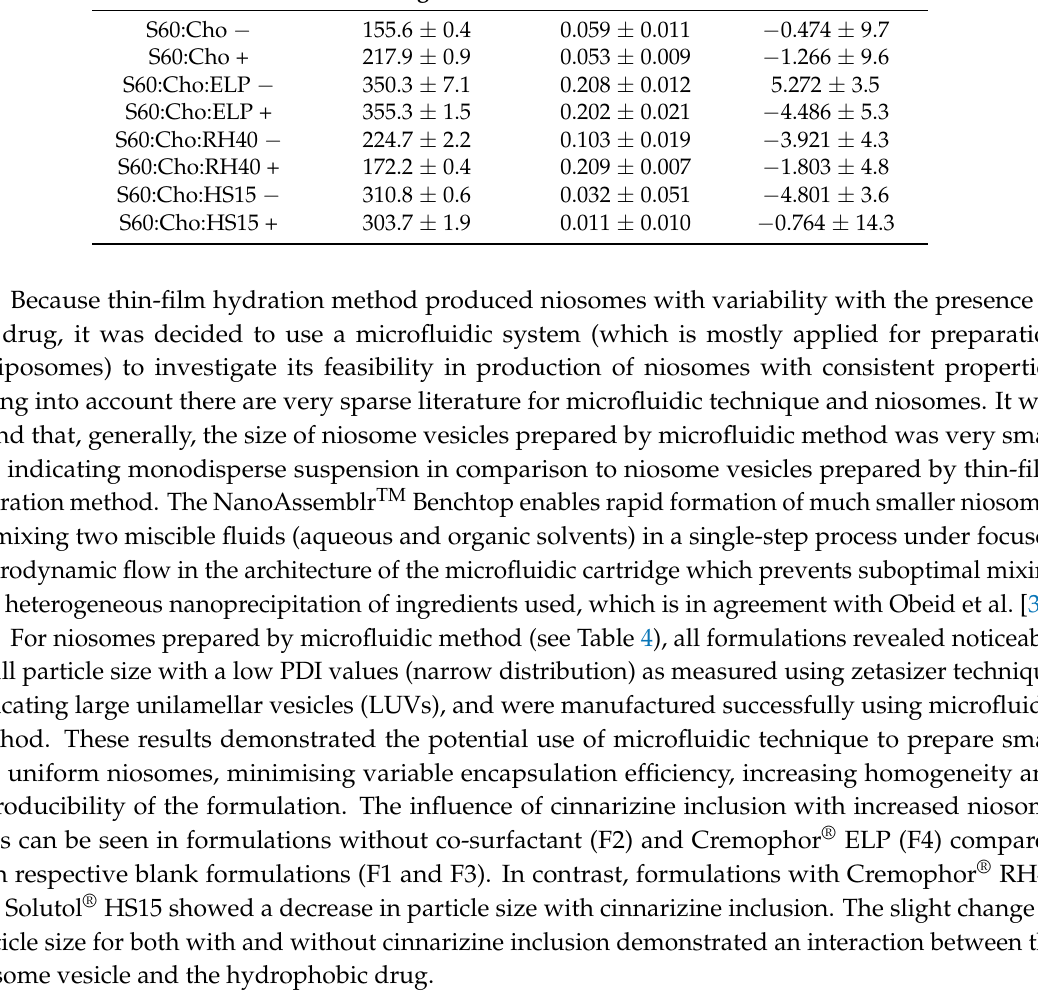
Table 4. Size of niosomes prepared by microfluidic method. For formulation composition, refer to Table 1.